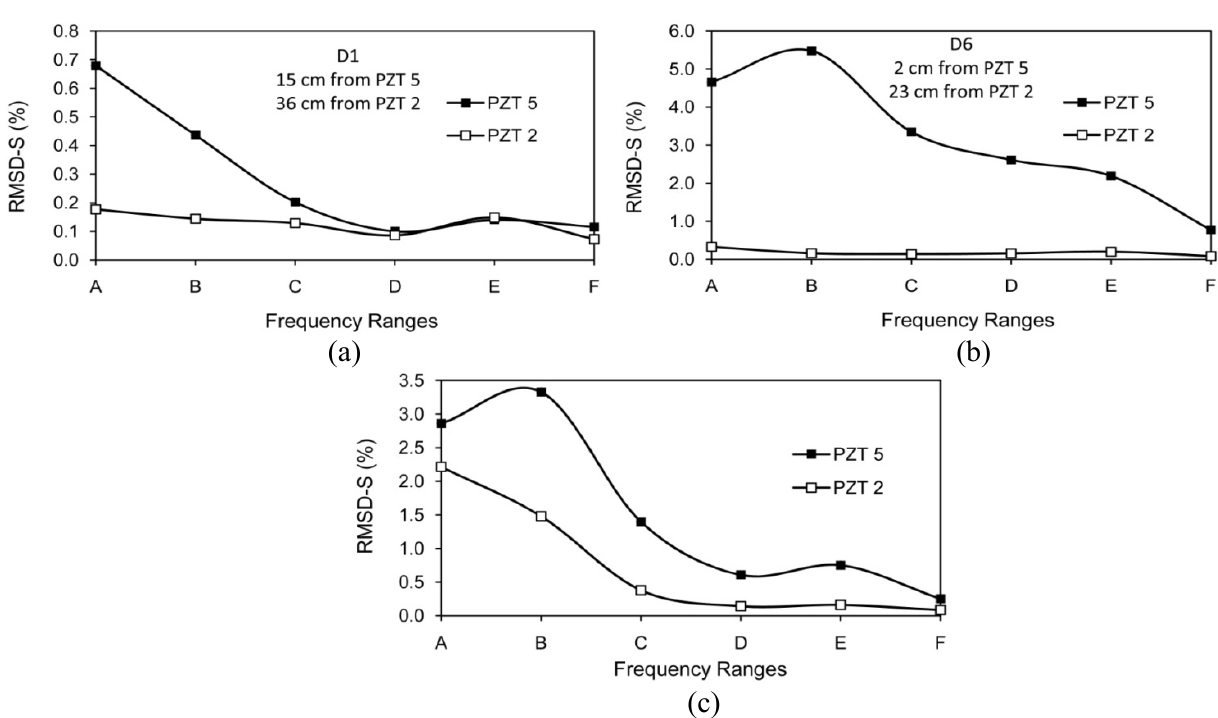
Figure 19. Predicted location of damage for various RMSD-S, (a) Damage in area (A) of region Z, (b) Damage in area (E) or (F) of region Z, (c) Damage in region Y in area (A) or (B) for PZT 2 which overlaps with area (C) to (E) for PZT